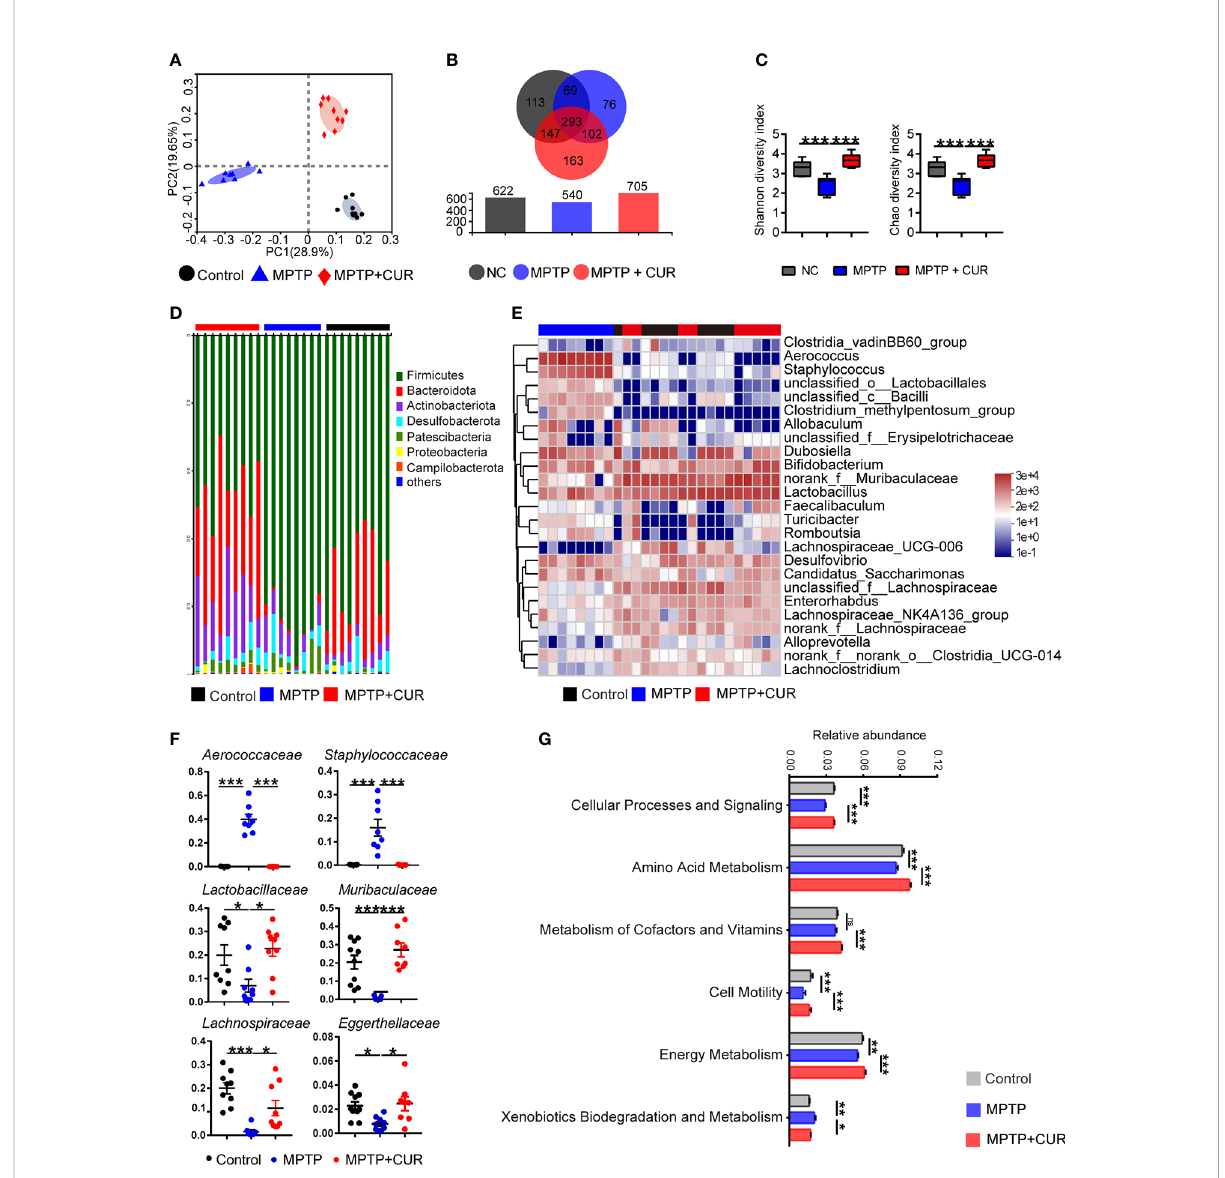
FIGURE 3 CUR administration alters the pro fi le of gut microbiota in MPTP-induced PD mice model. Male C57BL/6 mice were received intragastric administration of CUR (100 mg/kg) once a day for 4 weeks. On day 15, mice were treated with 200 m L saline containing MPTP (30 mg/kg) or 200 m L saline via intraperitoneal injection every day for a total of 5 times to establish PD mice model. On day 28, fecal pellets were collected from the mice to detect the gut microbiota by using 16S rRNA sequencing (n = 8-10). (A) The PCoA plot of MPTP treated mice, CUR treated mice and controls. (B) Venn diagram of shared and unique OTUs among 3 groups. The histogram represents the number of OTUs of each group. (C) The Shannon index and Chao index of MPTP treated mice, CUR treated mice and controls. (D) Composition of gut bacteria at phylum level shows a decrease in the abundance of Bacteroidota and an increase in abundance of Firmicutes in MPTP group compared with the other two groups by a bar plot. (E) Composition of top 25 genera at genus level between 3 groups using a heatmap. (F) Relative abundances of Aerococcus , Staphylococcaceae , Lactobacillaceae , Muribaculaceae , Lachnospiracea , Eggerthellaceae at family level using scatter points diagram. (G) Relative abundances of KEGG pathway level 2 classi fi cations between MPTP mice and CUR mice using a bar plot. Data are expressed as mean ± SEM. All statistical differences were tested using one-way ANOVA in (C, F, G) * p < 0.05, ** p < 0.01, *** p < 0.001n.s, not signi fi